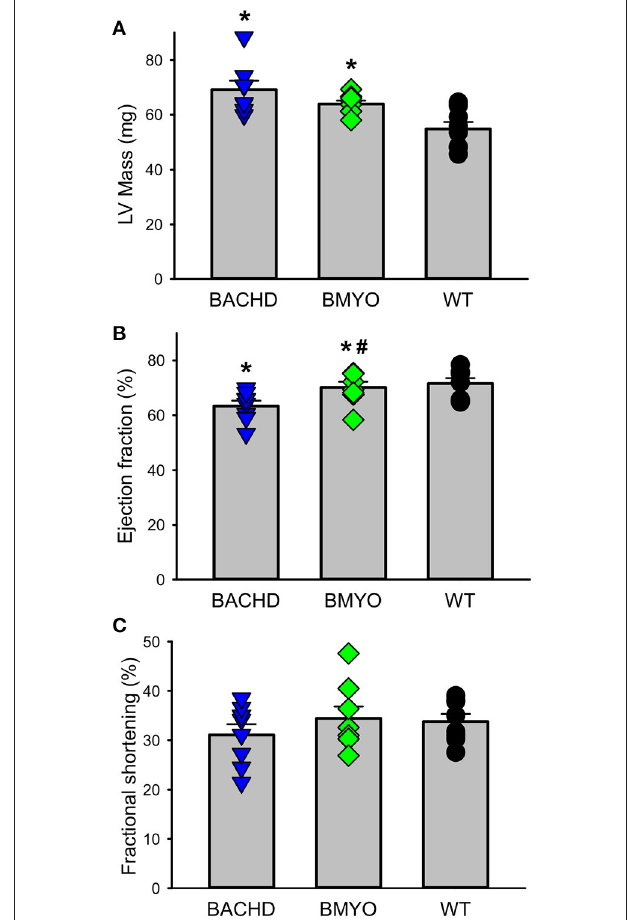
FIGURE 3 | Echocardiographic measurements of BACHD, BMYO, and WT animals at 6 months of age. Two-dimensional, M-mode echocardiography and spectral Doppler images enabled measurement of heart dimension and function including Left ventricle mass (LV mass), fractional shortening (FS%), Lv Ejection Fraction (Lv EF), and heart rate. Most parameters did not vary between the genotypes ( Table 1 ). (A) Lv mass was increased in both the BACHD and BMYO mice compared to WT controls, while (B) the ejection fraction was reduced in BACHD compared to BMYO and WT hearts. (C) The fractional shortening followed a similar pattern although the differences were not significant by our criterion. The selective reduction of mHtt from the heart did not reduce the hypertrophy in the BMYO heart but seemed to improve the ejection fraction. The vertical bar plots show group means and SEM. The symbols show the values from individual animals ( n = 7–8 per genotype). Asterisks represent significant differences ( P < 0.05) compared to WT controls while crosshatch indicates significant differences ( P < 0.05) between BMYO and BACHD. One way ANOVA followed by Tukey’s multiple comparison test was used to evaluate the possible significance of the findings (see Table 1 ).